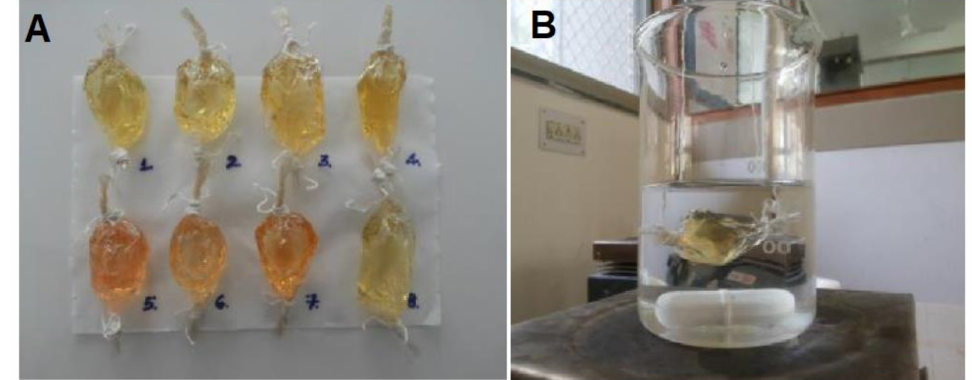
Figure 1. Experimental setup for determination of dissolution efficiency (%); ( A ) SNEDDS formula- tion filled in dialysis bag; ( B ); dialysis bag in a beaker while